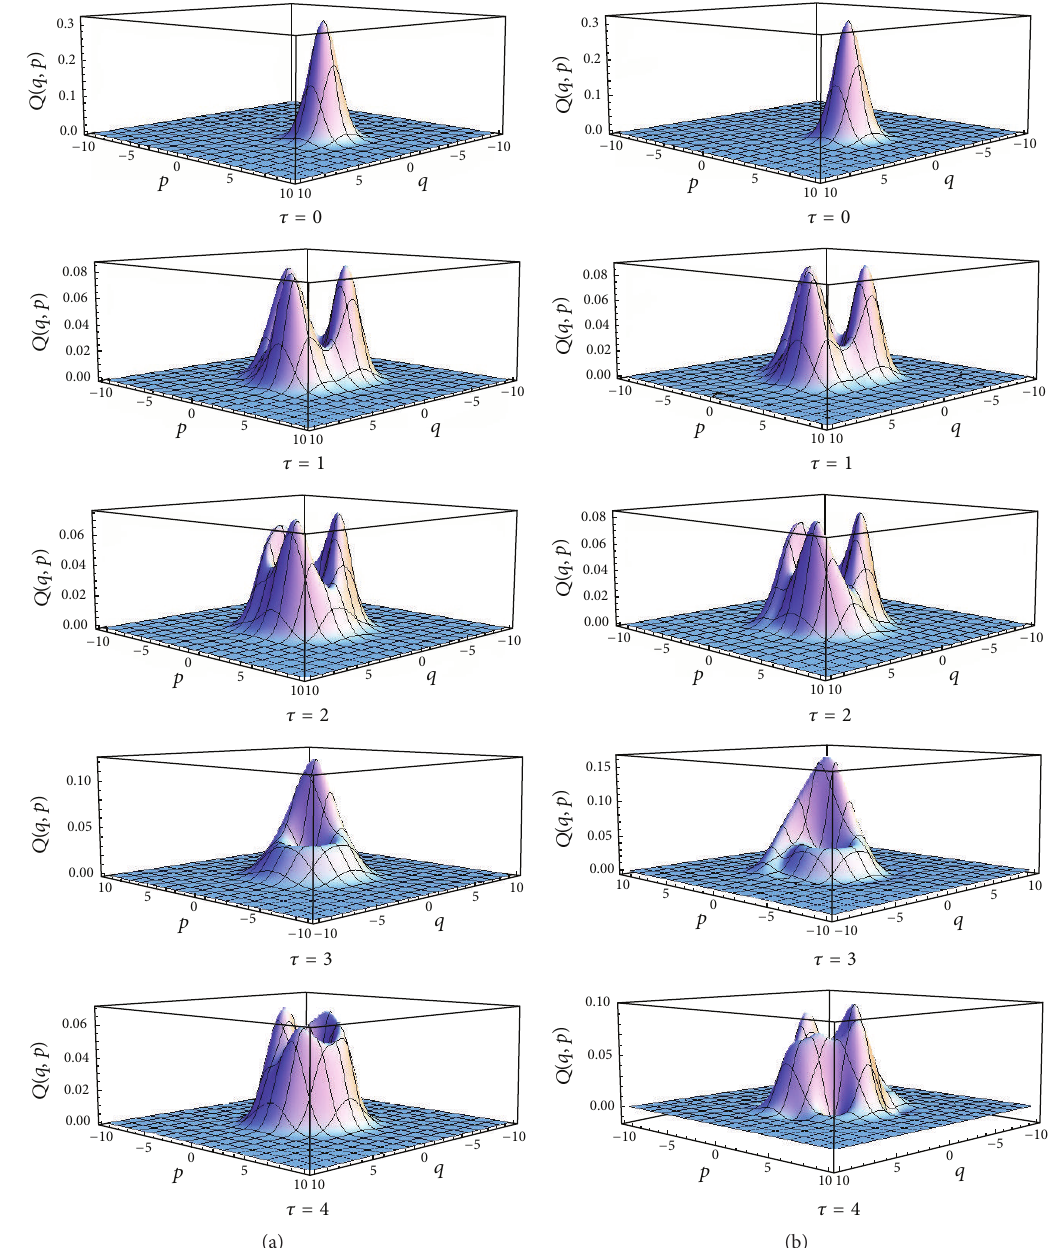
Figure 1: Evolution of the 𝑄 -function with 𝛼 = 2 and 𝜆 = 0.05 . (a) Exact solution and (b) approximated solution.